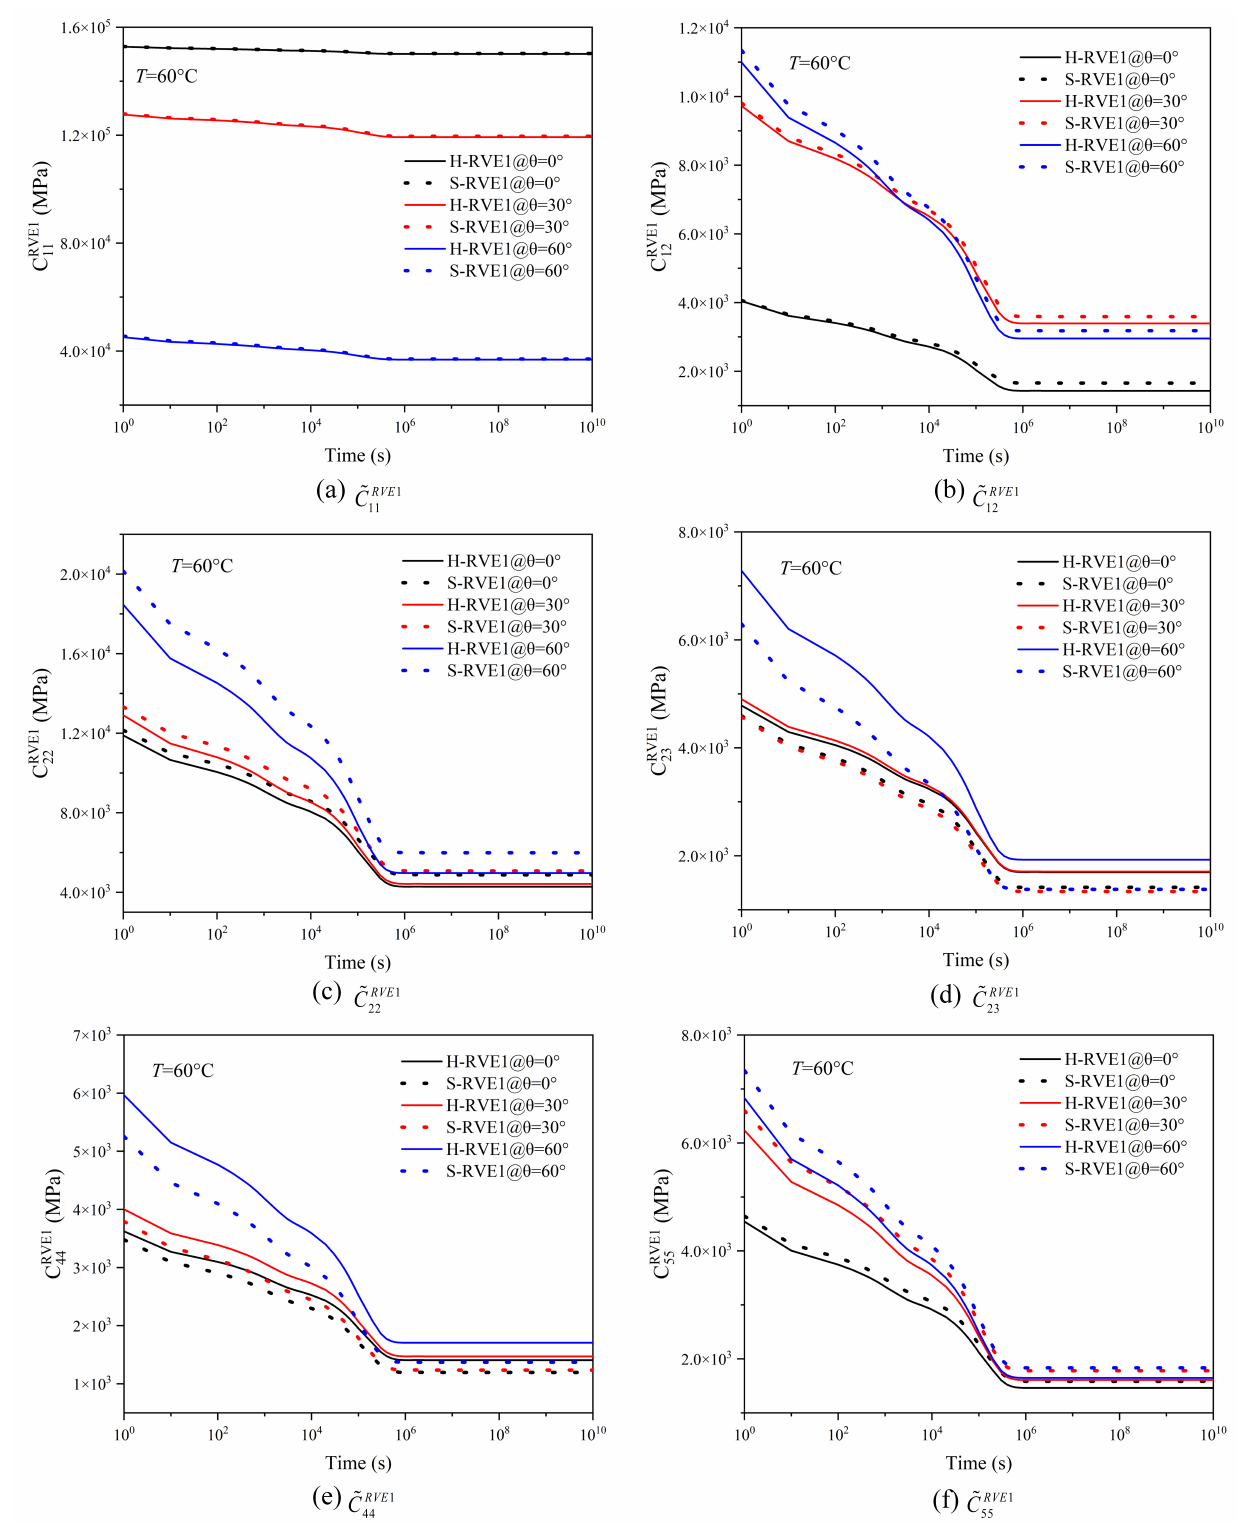
Figure 10.Figure 10. Effect of the twist angle on the effective relaxation stiffness tensors of the